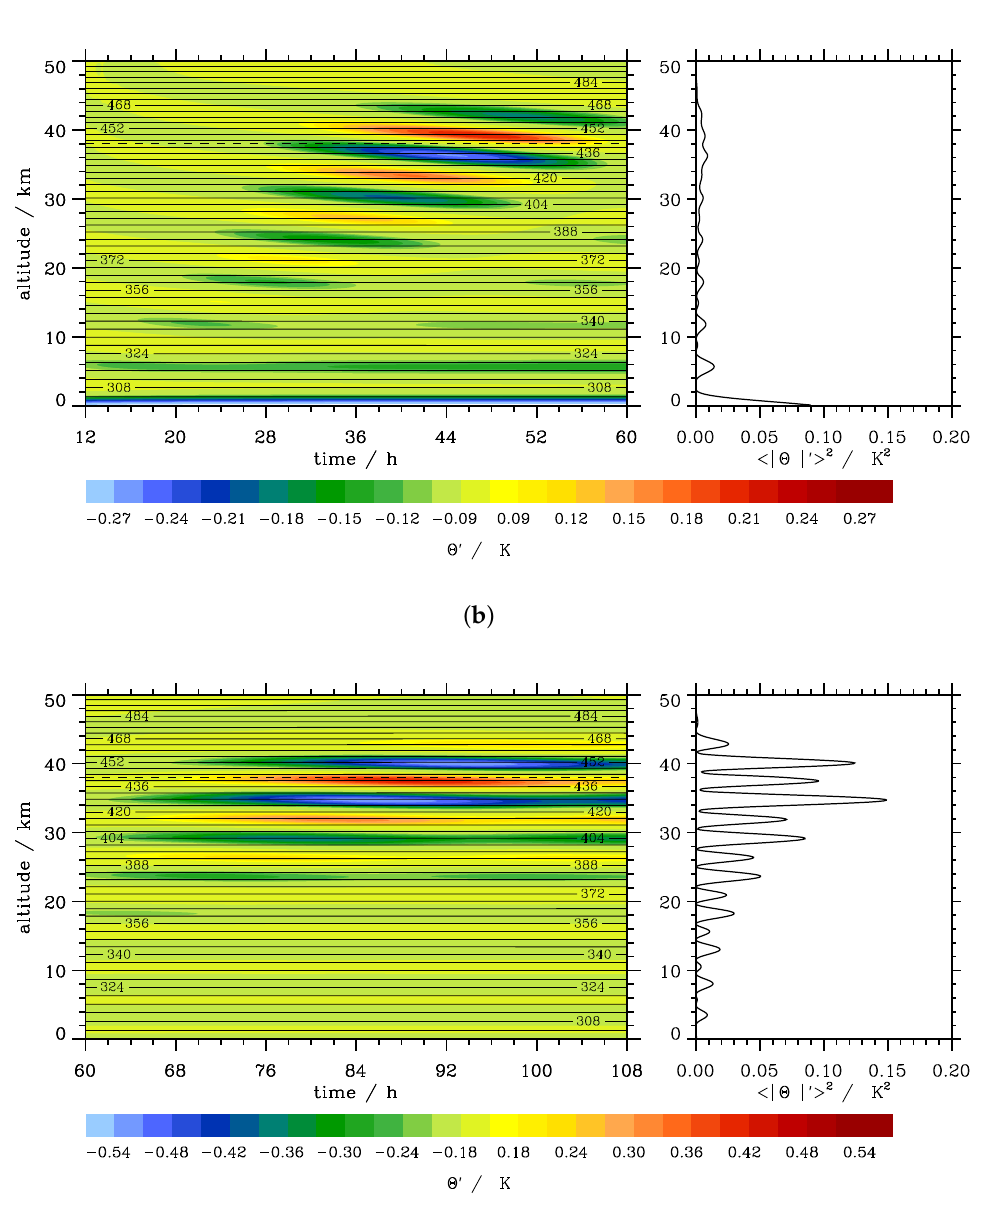
Figure 11. Vertical time series of the potential temperature perturbations Θ (cid:48) from wave regime (iii) directly above the mountain ( a ) at x = 0 and ( b ) at x = 500km for two different periods. The right panels depict the time-averaged | Θ (cid:48) | 2 -profiles over the respective